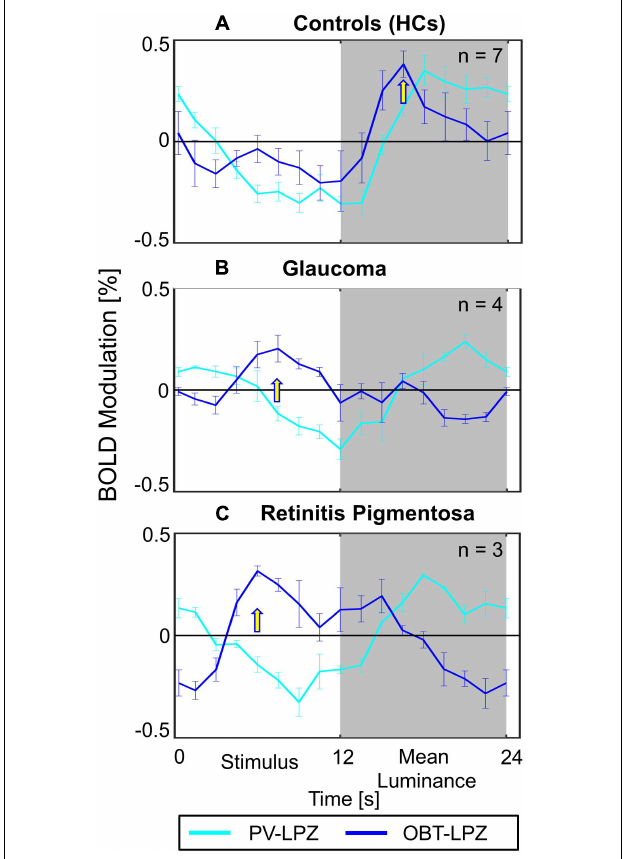
FIGURE 4 | Average single-cycle BOLD time series ± SEM. Group-averaged fMRI response modulation across participants of V1 LPZ during PV (cyan) and OBT (blue) conditions. The panels show the plots for (A) HCs (B) Glaucoma (C) Retinits Pigmentosa. Yellow arrows indicate time-points with peak responses for OBT; the BOLD-peak for OBT shifts from the second block (12–24 s) in HC to the first block (first 12 s) in RP and